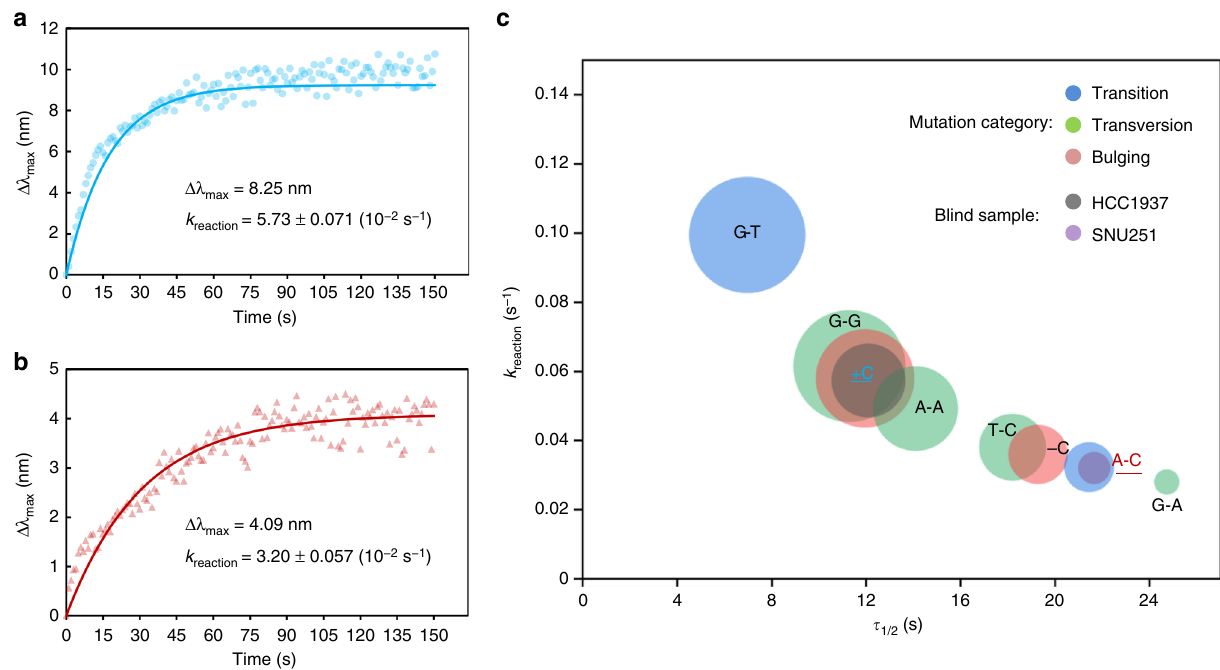
Fig. 7 Analysis of the presence and type of potential mutations in BRCA1 from human cancer cells. a Detection of the sample from breast cancer cells HCC1937. b Detection of the sample from ovarian cancer cells SNU251. c The k reaction values in ( a , b ) were input into the atlas, predicting mutations of + C and A – C, respectively. Source data are provided as a Source Data fi